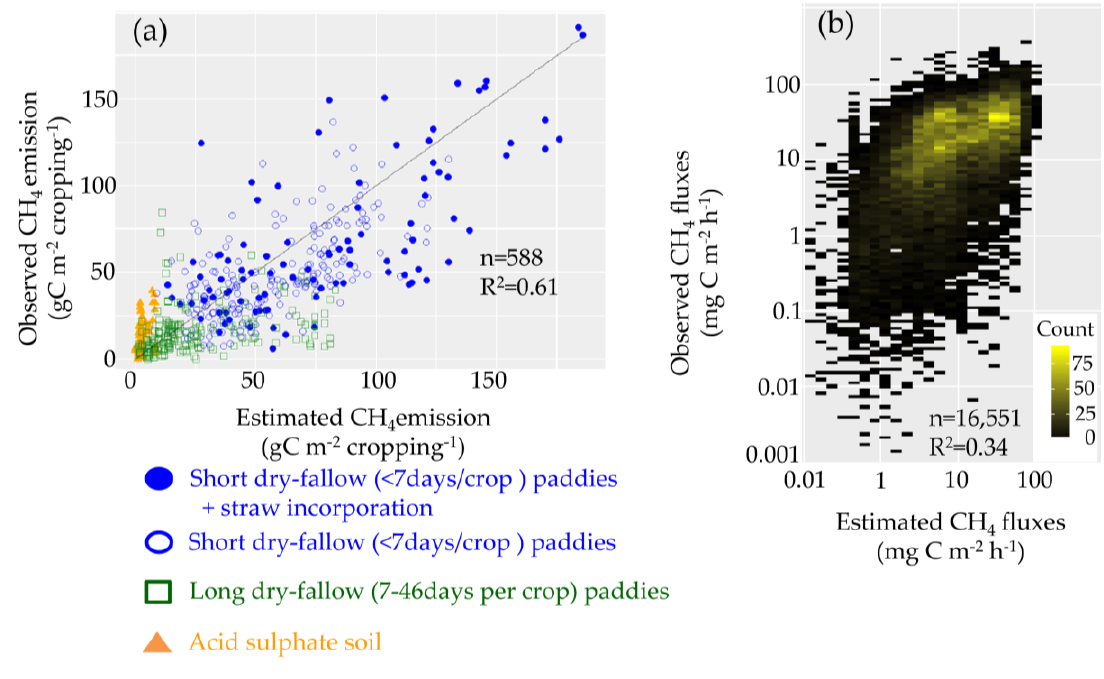
Figure 6. Scatter plots of model-simulated cumulative CH 4 emission values (g C m − 2 cropping − 1 , n = 558, Equation (1), whose parameters were substituted with their own posterior distribution mean values described in Table 1) and field-observed cumulative CH 4 emission values ( a ); model-simulated methane (CH 4 ) flux values (mg C m − 2 h − 1 , n = 16,551, Equations (2)–(4), whose parameters were substituted with their own posterior distribution median values described in Table 2) and field-observed CH 4 flux values ( b ). The horizontal axis shows the model-simulated values computed with a hierarchical Bayesian analysis. The vertical axis shows the field-observed values. The blue closed circles illustrate rice paddies in a short dry fallow period (<7 days/cropping, noninundated during the fallow period), where rice straw is fully incorporated into the soil; the blue open circles illustrate rice paddies in a short dry fallow period, where straw is burnt off or removed for rice-mushroom cultivation; the green open square plots illustrate rice paddies in a long dry fallow period ( ≥ 7 days/cropping, noninundated during the fallow period); and the orange triangular plots illustrate rice paddies in acid sulfate soils in the subfigure ( a ).